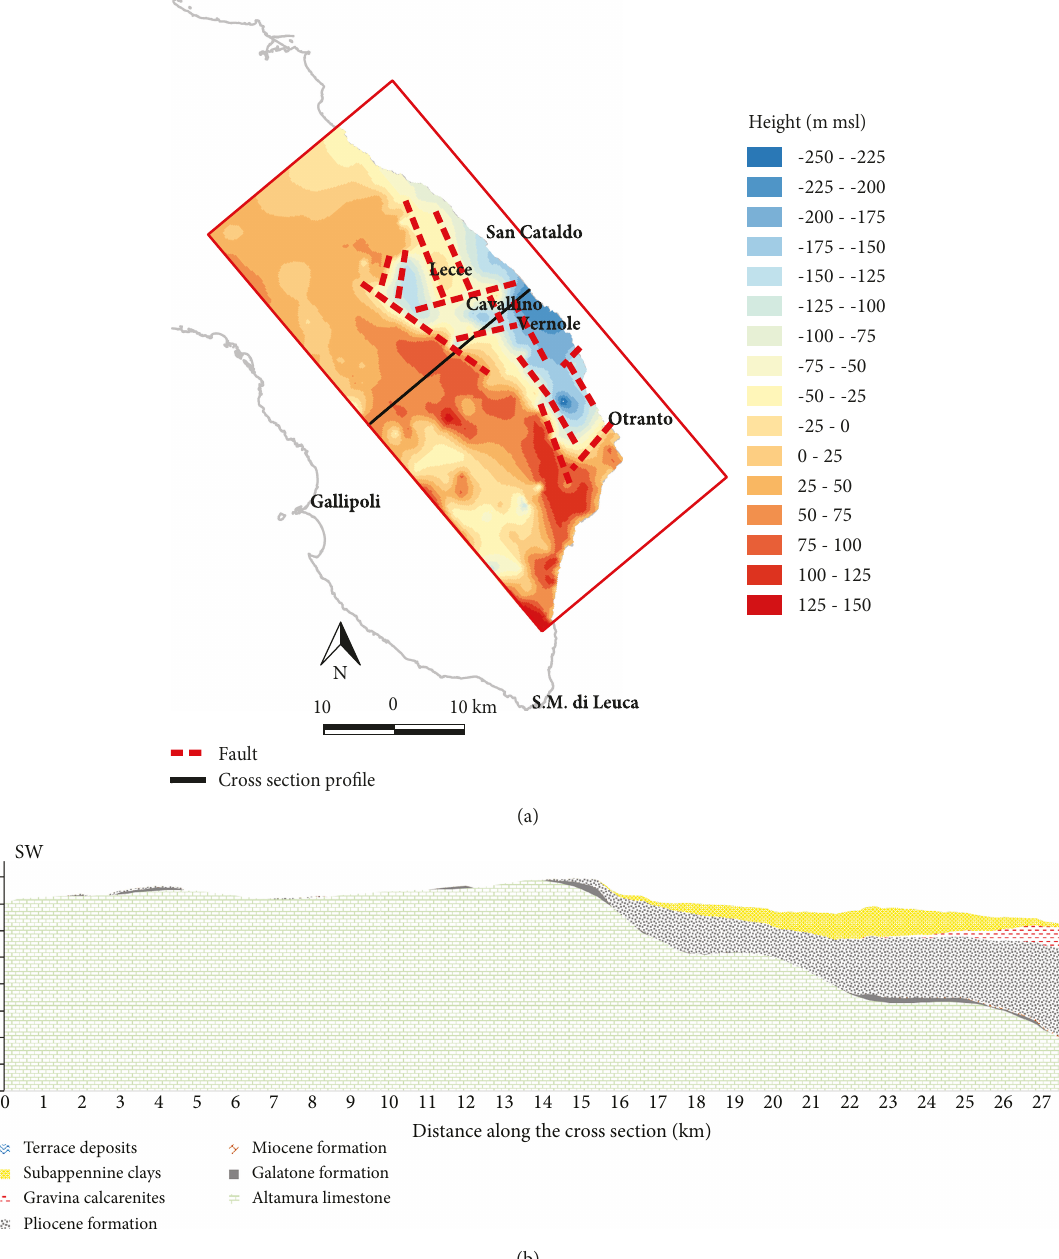
Figure 3: (a) Top elevation of the deep aquifer. (b) Stratigraphic cross section along the SW-NE pro fi le drawn in sub fi gure